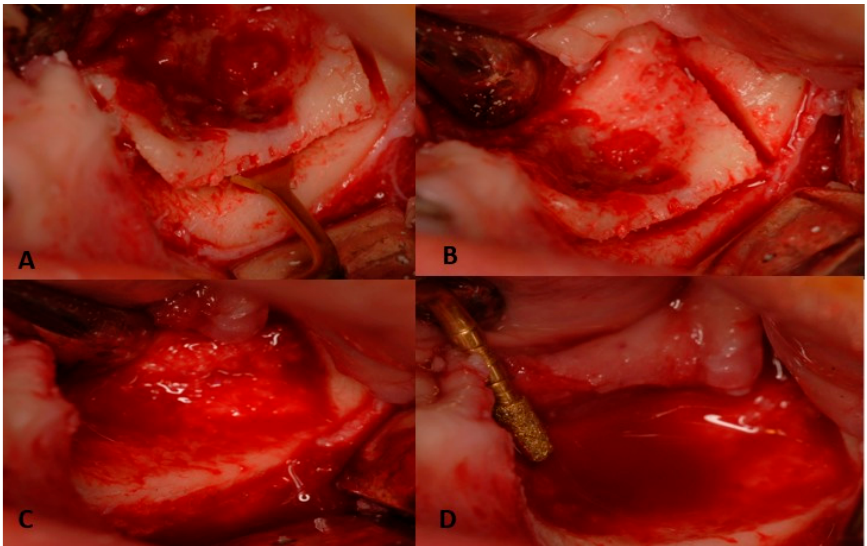
Figure 13. OPT of initial lesion pointed by the circle.